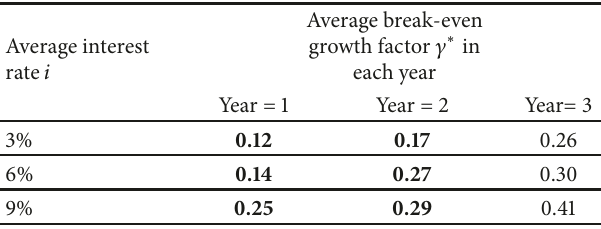
Table 5: Year-by-year averagebreak-evengrowing factorof the total population with respect to different average interest rates.